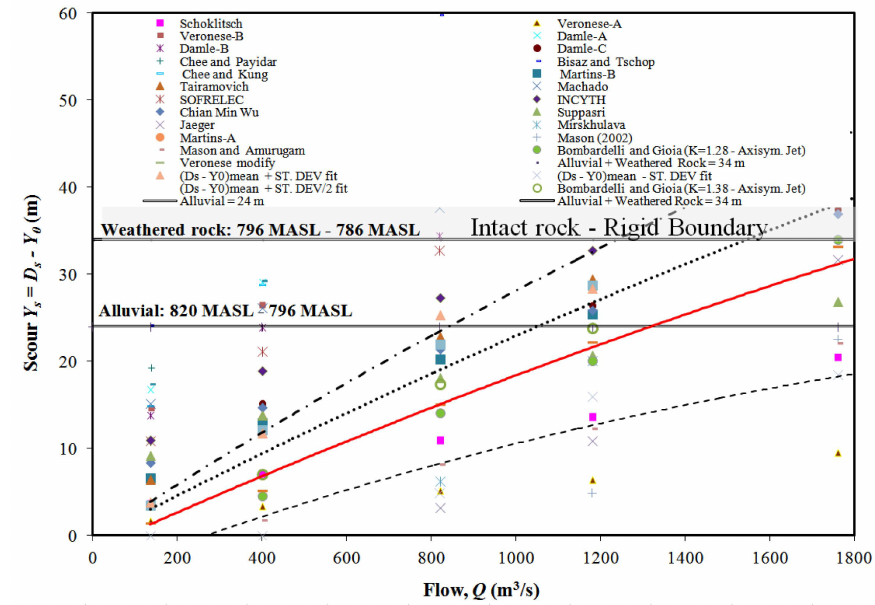
Figure 3. Scour of alluvial and weathered rock for the half-height